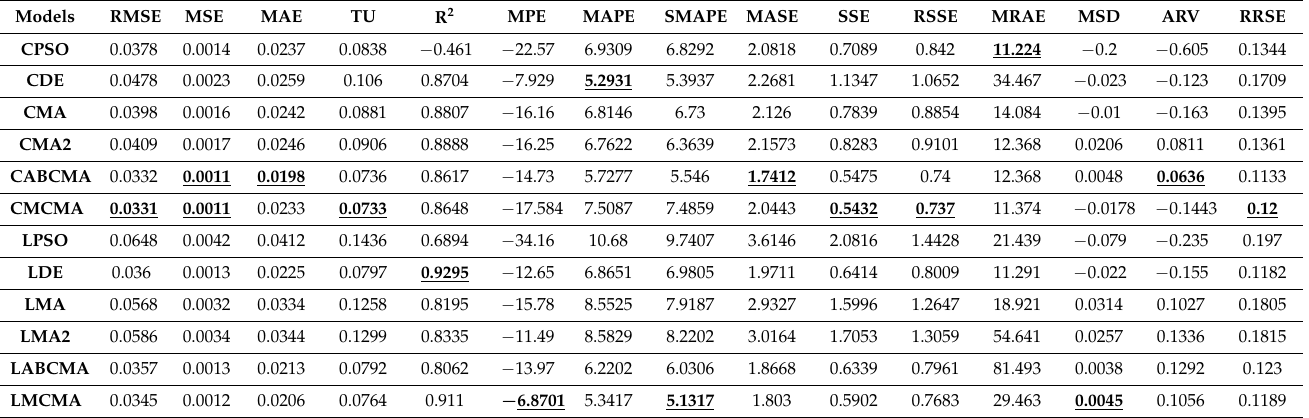
Table 4. Performance Metrics for BTC/EUR